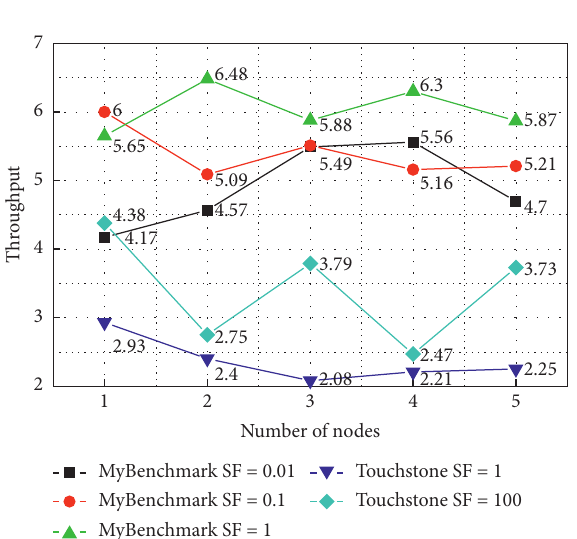
Figure 3: Comparison of data generation throughput.